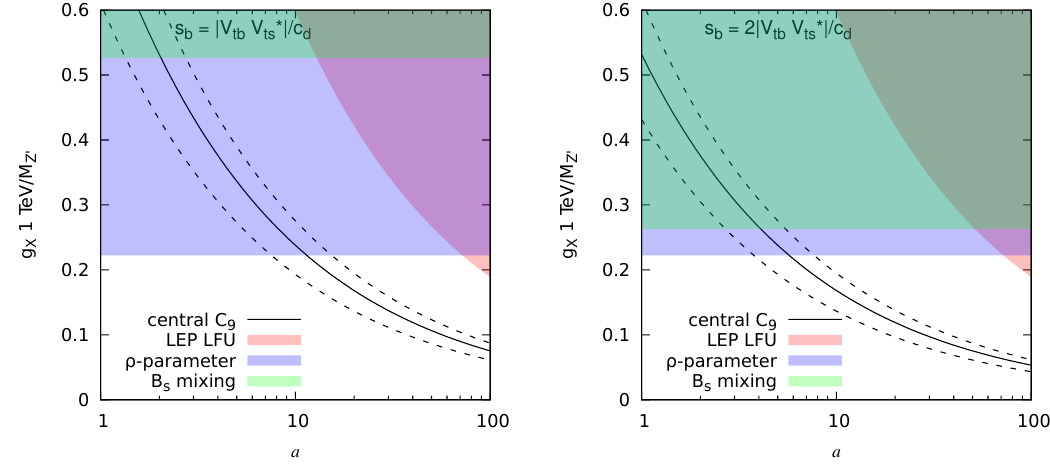
( L ) model introduced in this paper, in µ − L τ 6 . In both plots, b ¯ B s mixing, LEP LFU, and the s − ¯ B s mixing and the